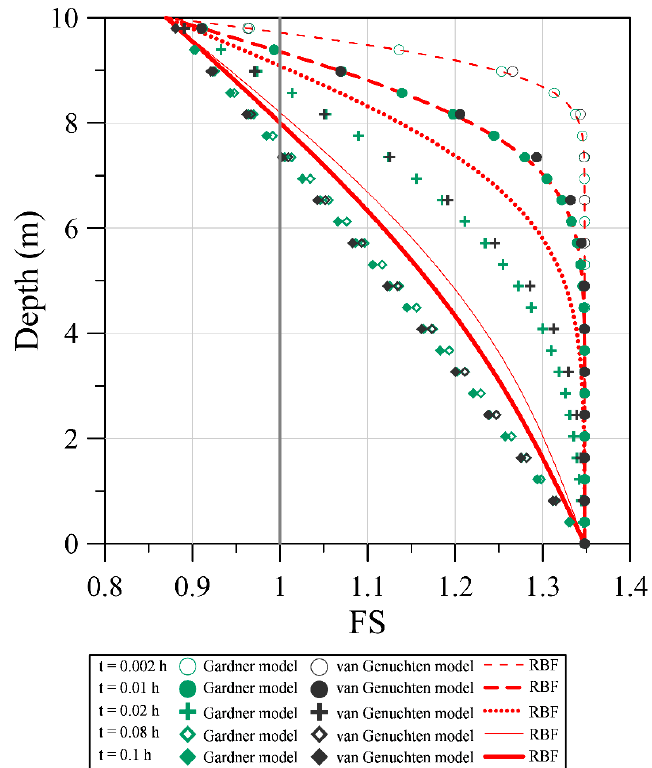
Figure 15. Computed FS.